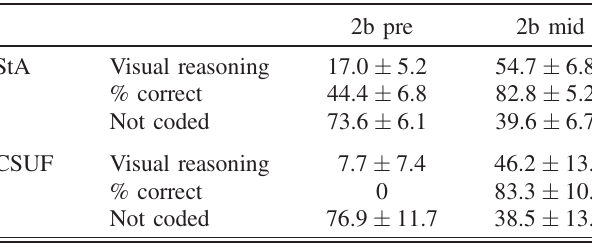
TABLE IV. The percentage of pre- and midtest responses to question 2b that were coded as visual, and the percentage of correct reasoning of these